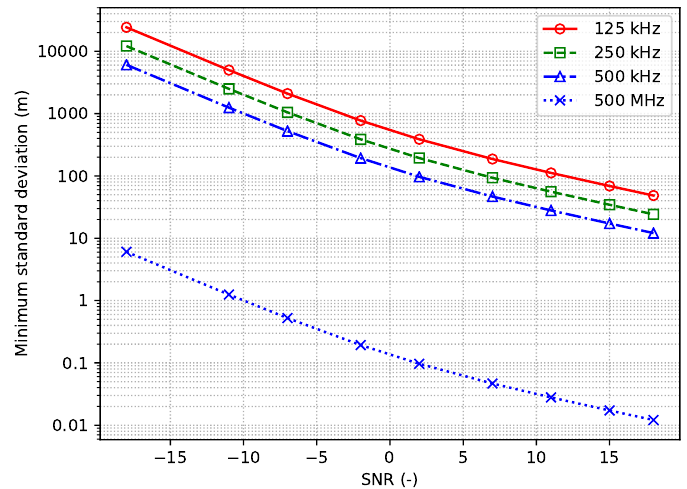
Figure 3. The Cramer–Rao bound for selected signal